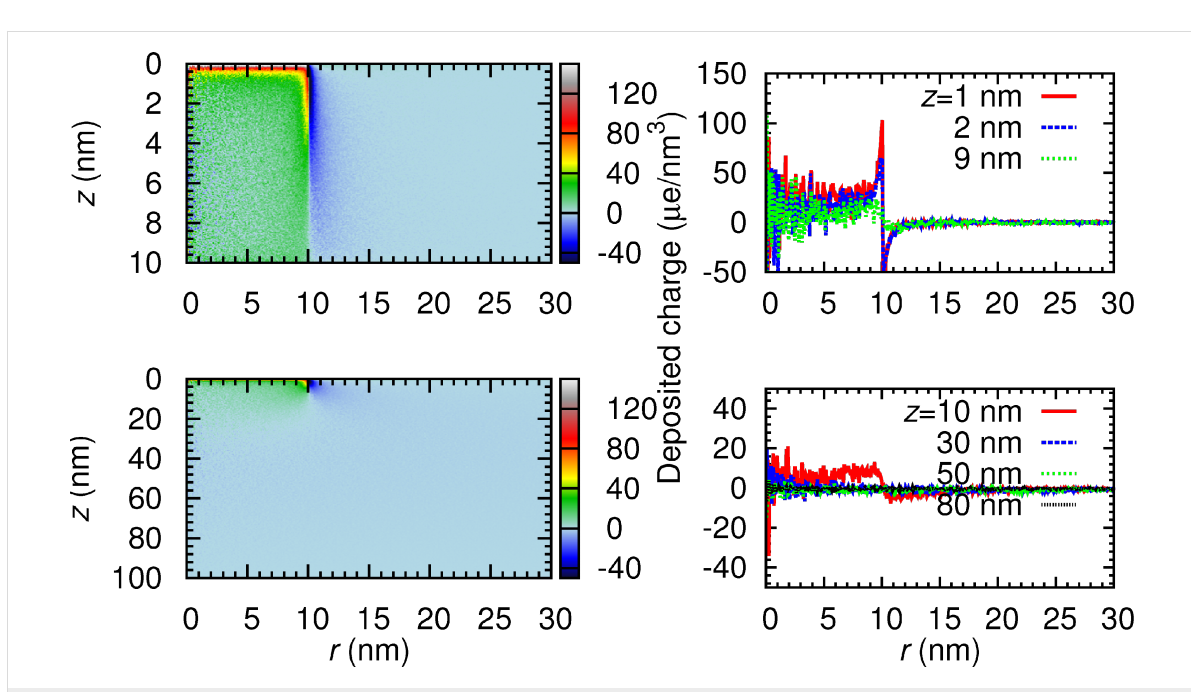
Figure 14: Same as Figure 13 for the charge deposited in WC 1.75 O 0.75 .